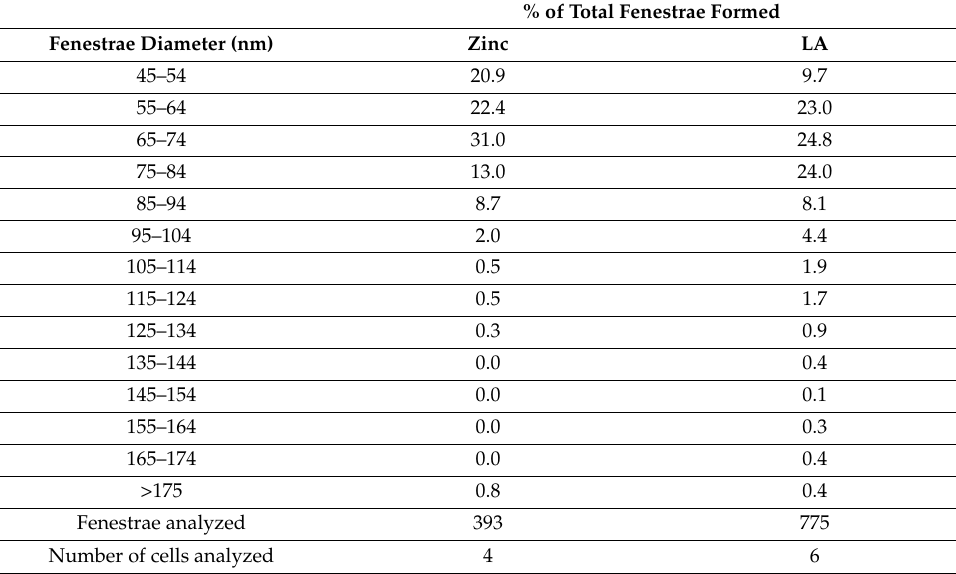
Table A1. Size distribution of fenestrae induced by zinc or